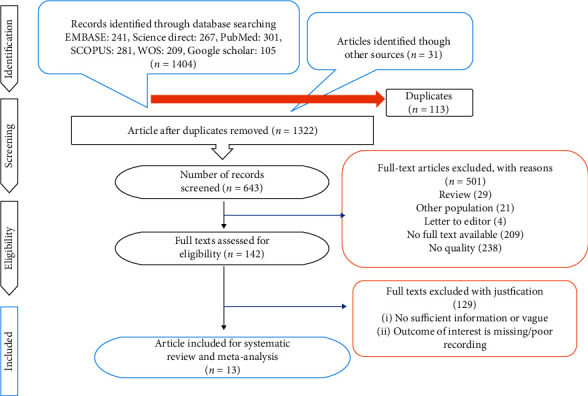
PRISMA flow diagram.